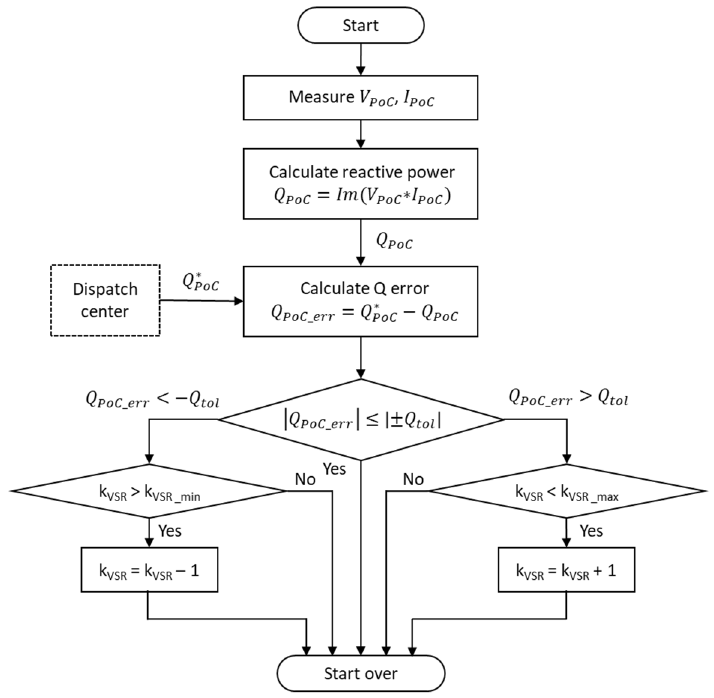
Figure 6. Block diagram of reactive power control of a VSR.